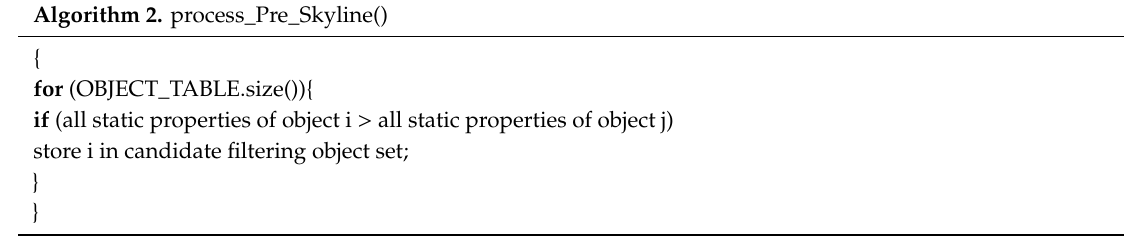
Algorithm 2. process_Pre_Skyline()